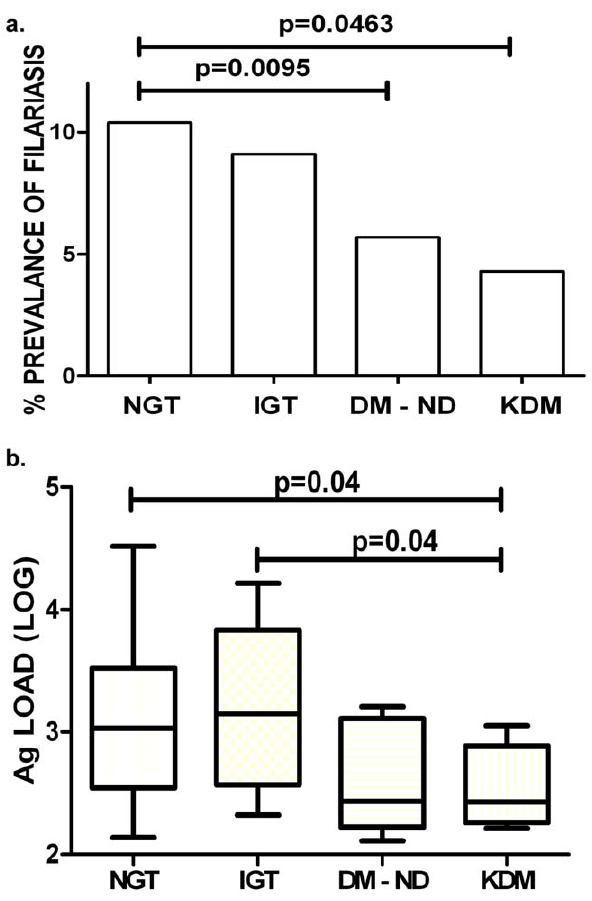
Figure 2. Anti-filarial antibody levels in diabetic (DM-ND-Newly diagnosed and KDM-Known diabetic) and non-diabetic (NGT- Normal glucose tolerance and IGT-Impaired glucose tolerance) subjects with active filarial infection. Box and whisker plots of the log transformed levels of IgG (Panel a) and IgG4 (Panel b) are shown for each of the four groups. NS=Not significant. Statistical differences in the antibody titer were determined by Mann-Whitney U test.